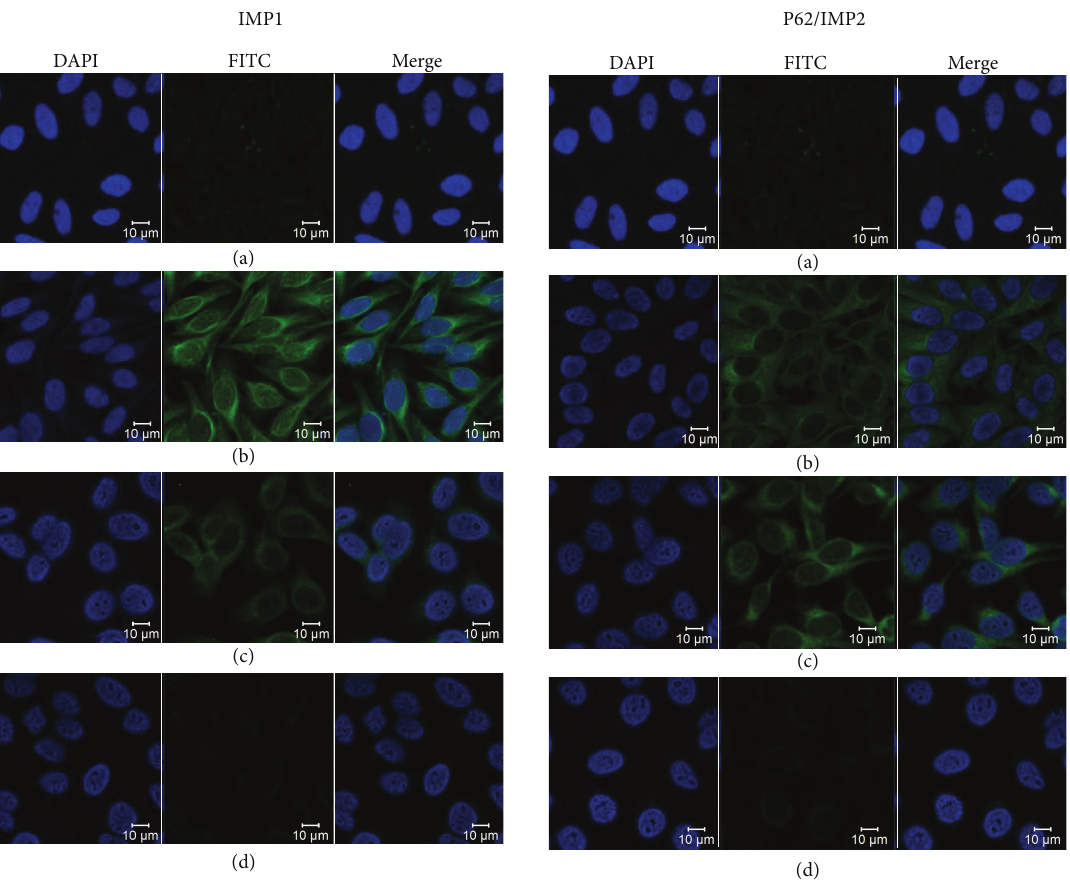
Figure 3: Representative immunofluorescence staining pattern of anti-IMP1 and anti-p62/IMP2 positive ovarian cancer sera. (a) A normal human serum (NHS) was used as negative control; (b) monoclonal anti-IMP1 or anti-p62/IMP2 antibody that demonstrated a cytoplasmic immunofluorescence staining pattern was used as positive control; (c) representative anti-IMP1 or anti-p62/IMP2 positive ovarian cancer sera demonstrated an intense cytoplasmic immunofluorescence staining pattern; (d) the same ovarian cancer serum that was used in panel (c) was postabsorbed with recombinant IMP1 or p62/IMP2 protein. The fluorescent cytoplasmic signal was remarkably